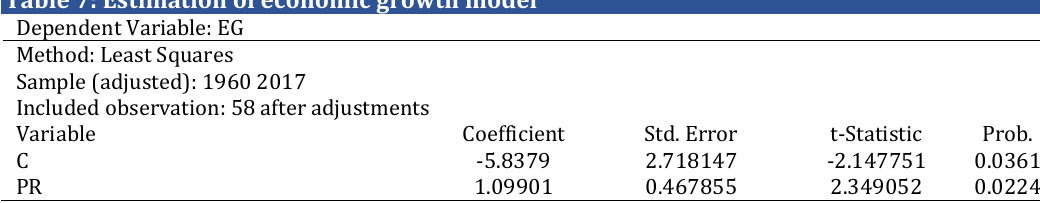
Table 7: Estimation of economic growth model